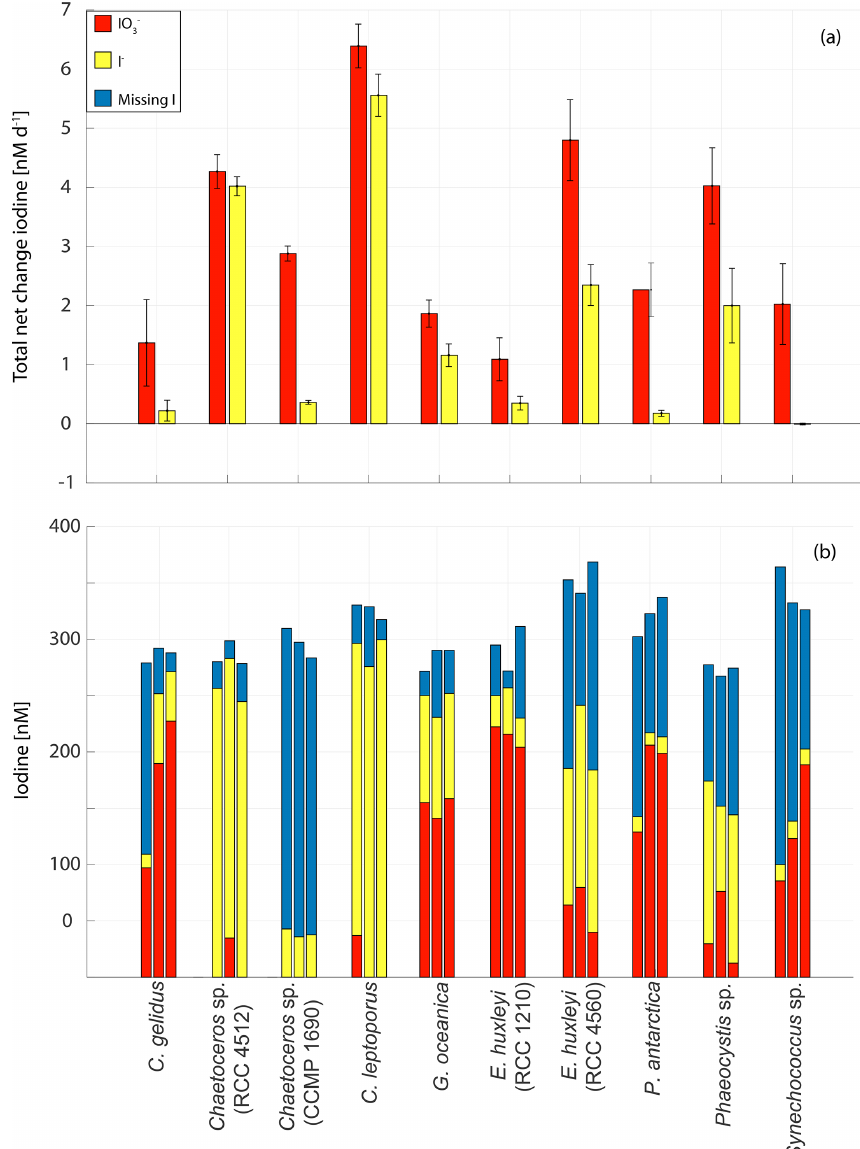
Figure 8. Changes in inorganic iodine speciation in 10 marine phytoplankton cultures: (a) overall (whole experiment) rate of change in IO − (red) and I − (yellow) normalised for the duration of each experiment. Error bars show the standard deviation of three replicate cultures 3 and (b) total IO − (red bar), I − (yellow bar) and missing iodine (blue bar) for all three replicates for each experiment at the end of each 3